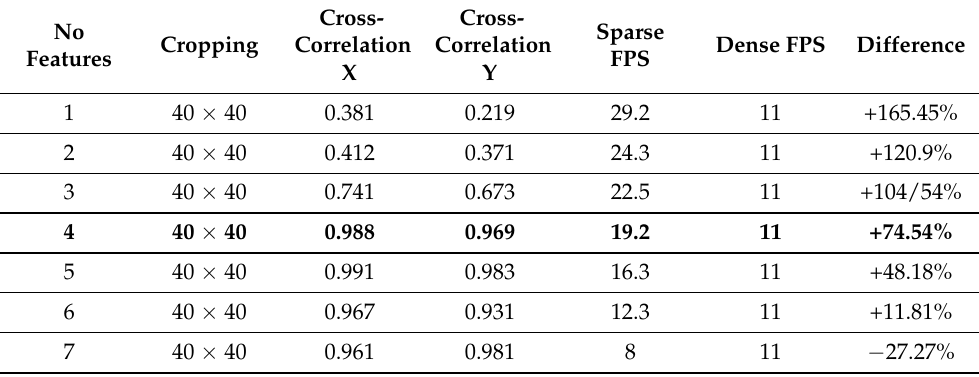
Table 3. The effect of “number of features” on accuracy and processing time of the model.